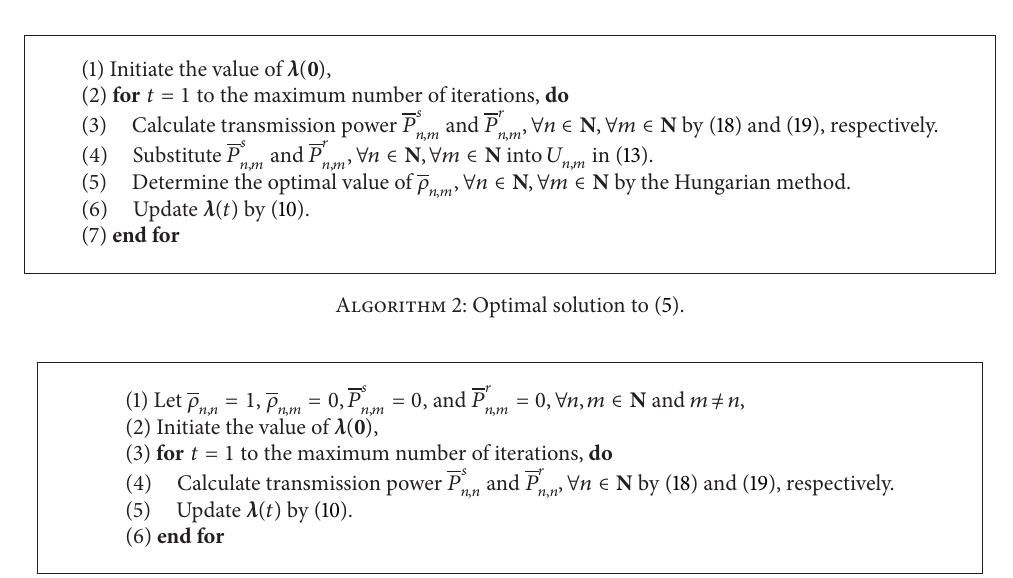
Algorithm 3: Suboptimal algorithm